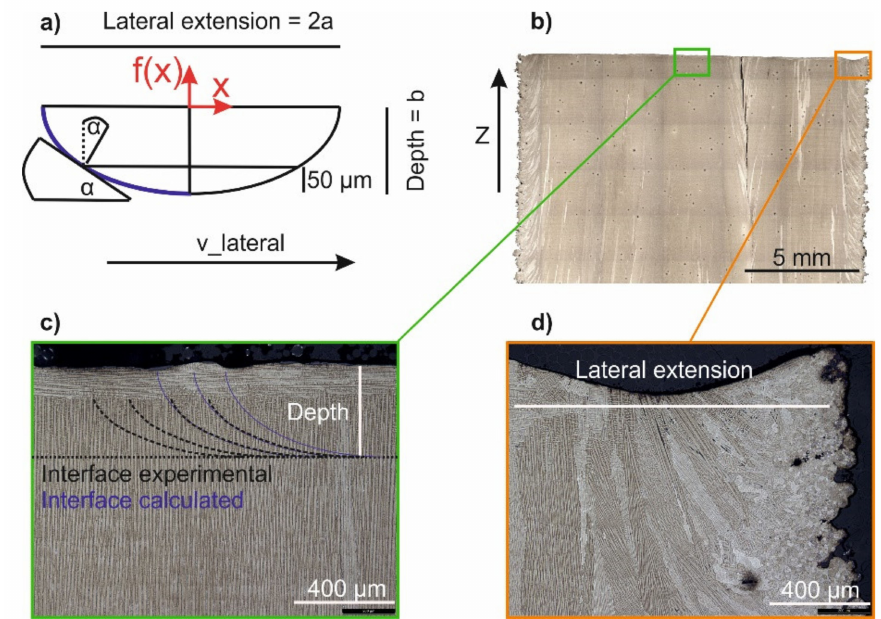
Figure 2. Melt pool characterization. ( a ): Thermal gradient at the solidification front is characterized by the angle α . ( b ): Overview image. ( c ): Determination of the melt pool depth based on experimental and analytically calculated rest-lines. ( d ): Determination of the melt pool lateral